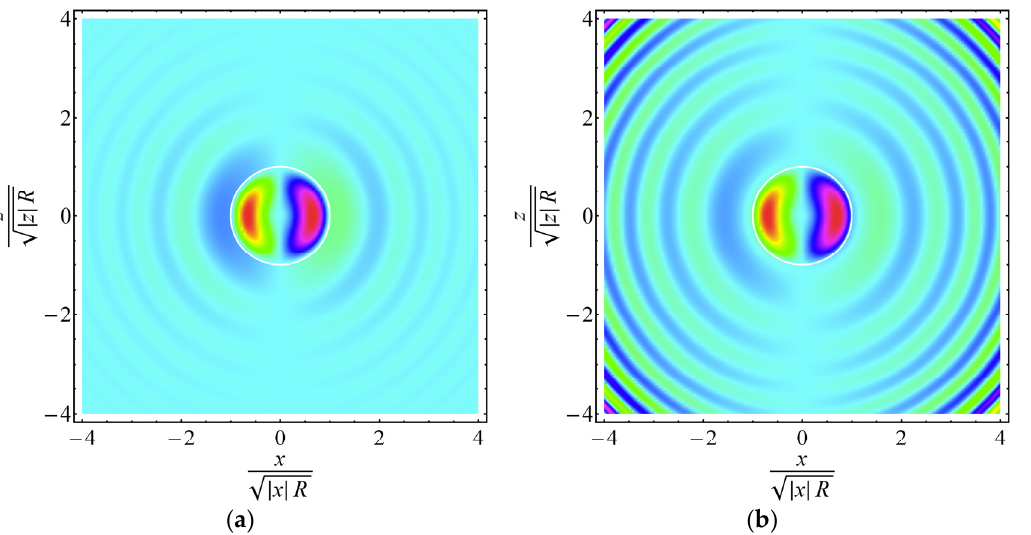
Figure A2 . Spatial distribution of Re H φ in ( a ) the perfect nonradiating PTM 101 mode ( k 0 R = 1.51893) Figure A2. Spatial distribution of Re H ϕ in ( a ) the perfect nonradiating PTM 101 mode ( k 0 R = 1.51893) and ( b ) the usual TM 101 mode ( k 0 R = 1.35715-0.160978 i ) in a sphere of the radius R with ε = 10. and ( b ) the usual TM 101 mode ( k 0 R = 1.35715 − 0.160978 i ) in a sphere of the radius R with ε =